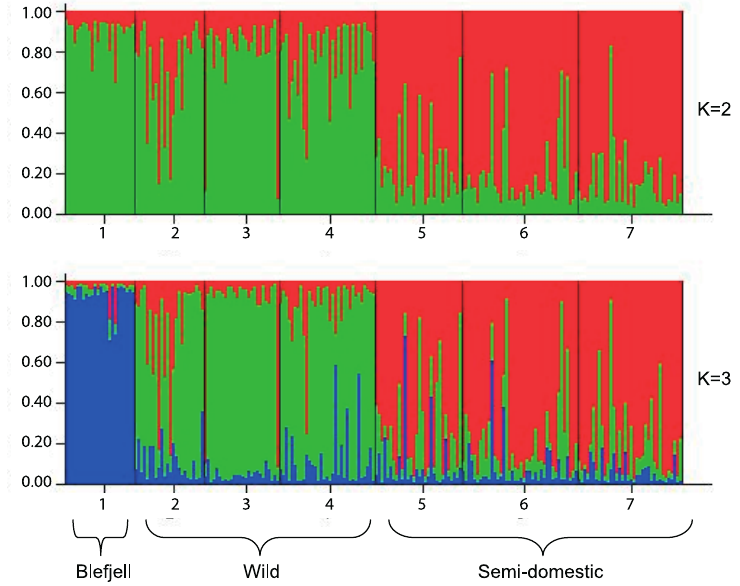
Fig. 5. Bayesian assignment of reindeer from Blefjell together with reference reindeer from three semi-domestic herds and three wild herds analyzed by SRUCTURE. Individual assignments are given to each of two (K = 2) and three (K = 3) clusters (different